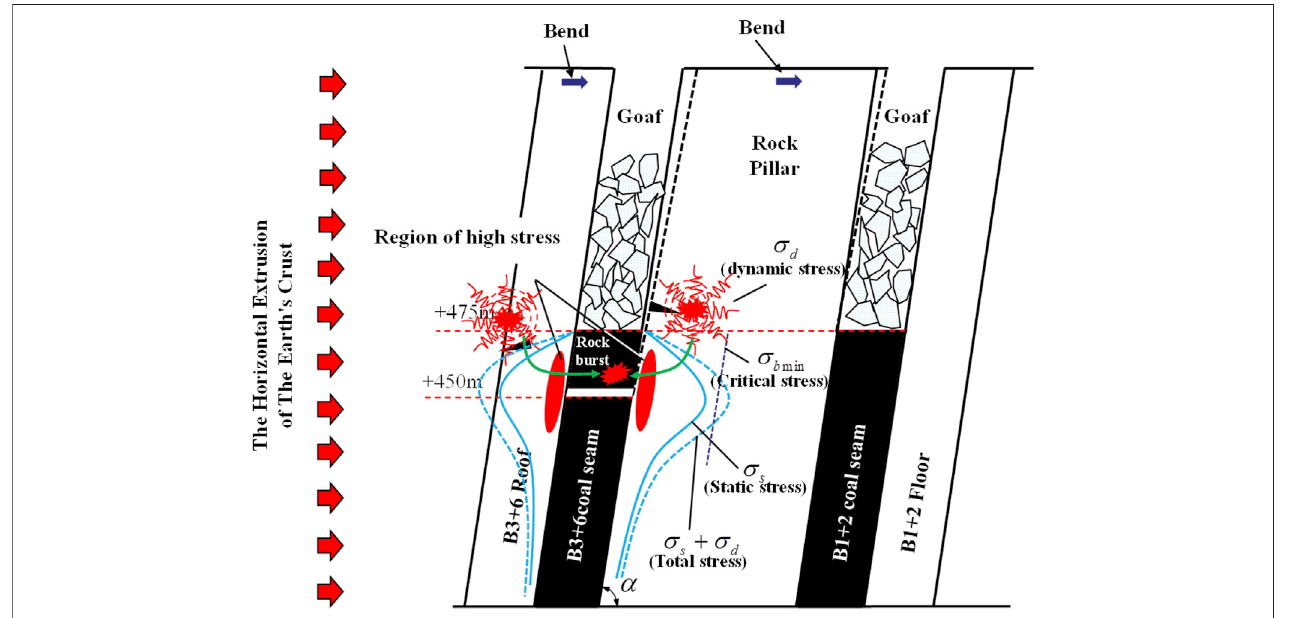
FIGURE 10 | Schematic diagram of the rock burst induced by superposition of the vibration wave load and static load.